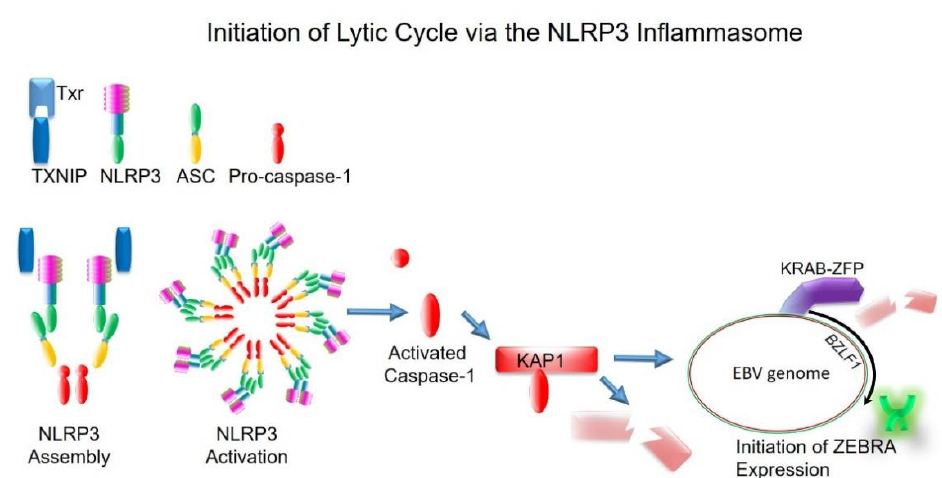
Figure 3. Model depicting NLRP3 inflammasome-mediated activation of the EBV replication switch. Shown are components of the NLRP3 inflammasome, including thioredoxin-interacting protein (TXNIP), the reactive oxygen scavenger thioredoxin (Txr), NLRP3 (NOD-, LRR- and pyrin domain- containing protein 3), apoptosis-associated speck-like (ASC) adapter protein, and pro-caspase-1. Exposure of EBV-infected B cells to a lytic trigger, such as a danger signal, results in upregulation of TXNIP via transcription and/or release from its binding partner Txr, precipitating NLRP3 assembly and activation. NLRP3 assembly/activation involves ASC-mediated recruitment of pro-caspase-1 to NLRP3 oligomers, resulting in intermolecular cleavage of pro-caspase-1 to active caspase-1. Caspase-1 destabilizes the key heterochromatin regulator KAP1, resulting in de-repression of BZLF1 . ZEBRA (green dimer) transactivates RTA and a multitude of other lytic genes, resulting in productive virus replication.